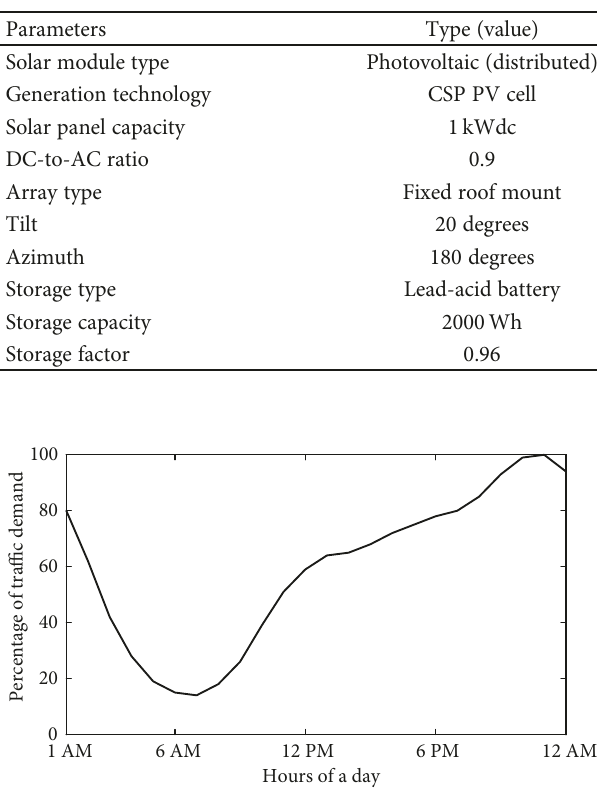
Figure 3: Daily tra ffi c pro fi le of a residential